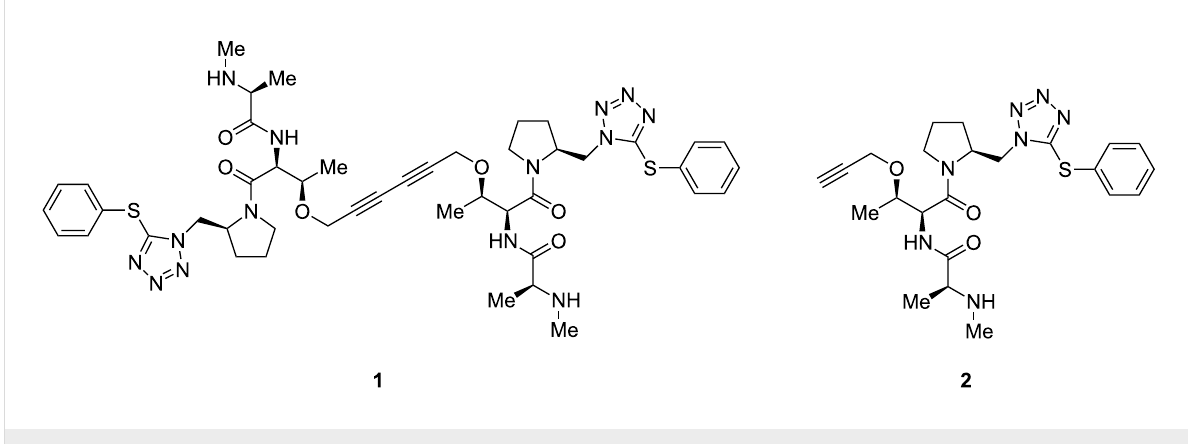
Figure 1: Apoptosis inducer C 2 -symmetric 1,3-diyne-linked peptide 1 and its inactive monomer 2 .